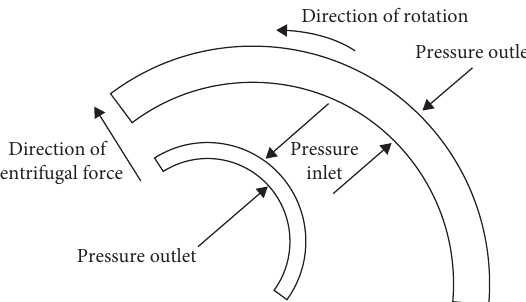
Figure 15: Schematic diagram of the influence of rotational speed on end clearance leakage.